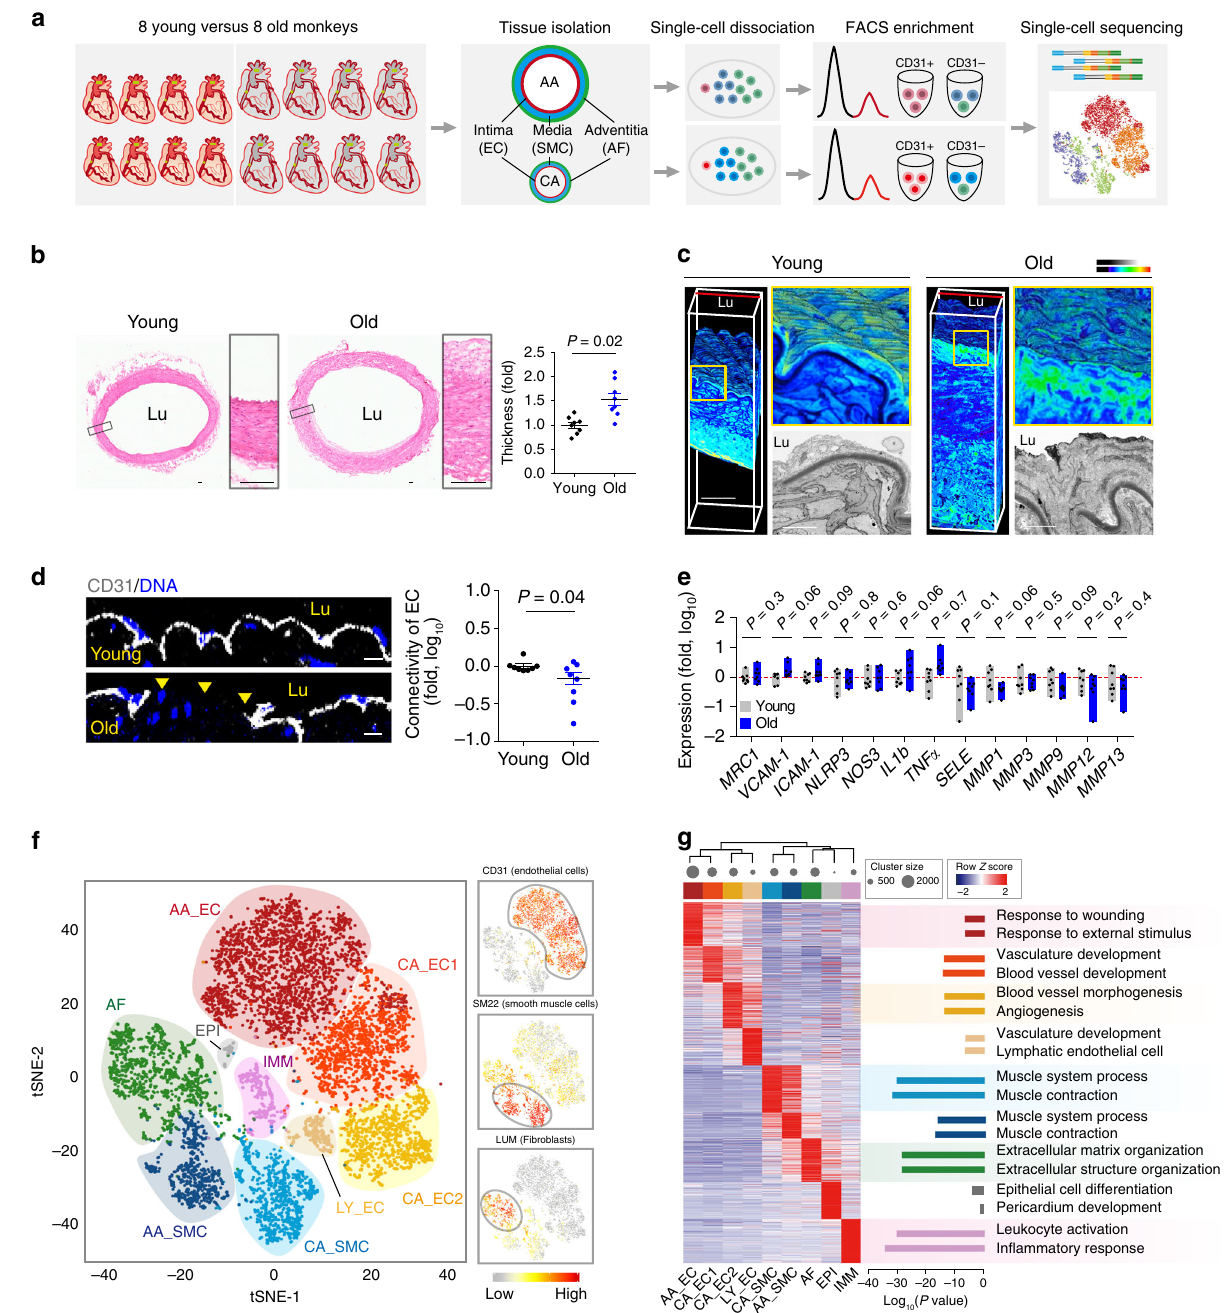
Fig. 1 Diversity of cell types identi fi ed by scRNA-seq analysis. a Method fl owchart. Aortic artery (AA), coronary artery (CA), endothelial cell (EC), smooth muscle cell (SMC) and adventitial fi broblast (AF) . b , Hematoxylin/eosin staining (left) and the calculated wall thickness (right) in vessel tissues from young and old monkeys. Rectangle, enlarged area. Scale bar, 100 μ m. c Large-scale three-dimensional reconstruction of a rectangular piece of vascular wall using automatic collector of ultrathin sections scanning electron microscopy (AutoCUTS-SEM). Left, volume electron microscopy. Upper right corner, enlarged area within the yellow rectangle. Lower right corner, representative section from the position of the red line before coloring with Imaris9.2.1 (color-key). See also Supplementary Fig. 1g. Scale bar, 100 or 10 μ m. d Left, immuno fl uorescence staining for CD31 in young and old monkey vessels in the vicinity of aortic arch. Right, quanti fi cation of the connectivity between ECs. Yellow arrowheads indicate points of disconnection between ECs in old monkeys. Scale bar, 25 μ m. e Bulk qPCR of proatherosclerotic and atherosclerotic genes in both young and old monkey vessels. f The position of the major cell classes in a